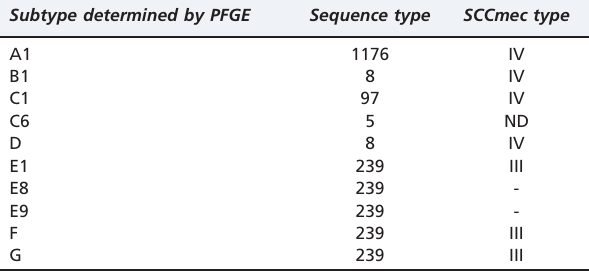
Table 3 - Multilocus sequence typing results for 10 methicillin-resistant S. aureus subtypes that colonized patients hospitalized in the dermatology unit over a period of 6 months.